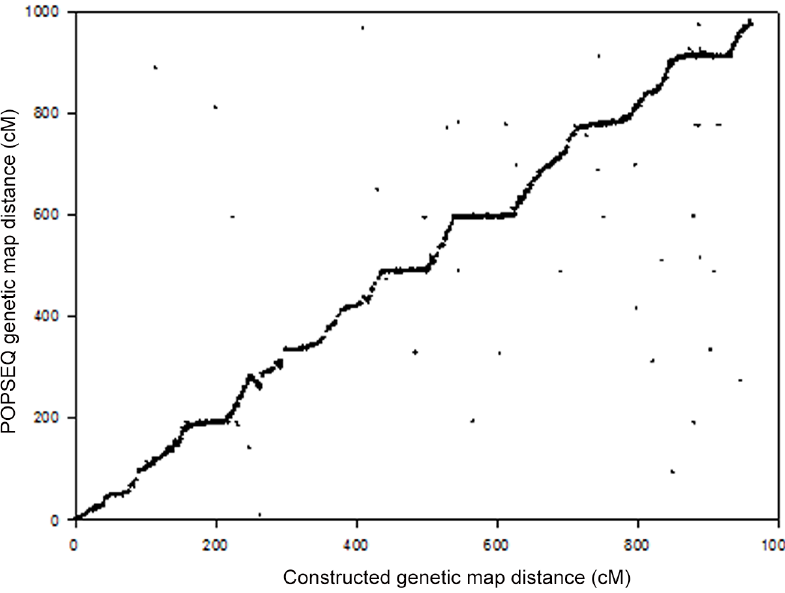
Fig 1. Alignment of genetic maps derived from de novo and POPSEQ. A total of 12,998 SNP markers were dotted in the figure. X-axis indicates the accumulative genetic position in the de novo genetic map; Y- axis indicates the accumulative genetic position in the POPSEQ genetic